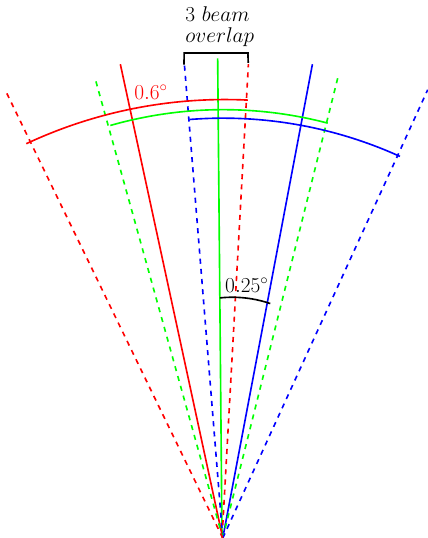
Figure 3. Schematic view of three 0.6 ◦ wide laser beams separated by 0.25 ◦ . The outer edges of the beams are illustrated by dotted lines in red, blue, and green, with the center of each beam marked with a solid line. Regardless of size, an object will be covered by at least three beams, due to the width of the beams, as can be seen around the solid green line in the center. 3 beam 0 . 6 ◦